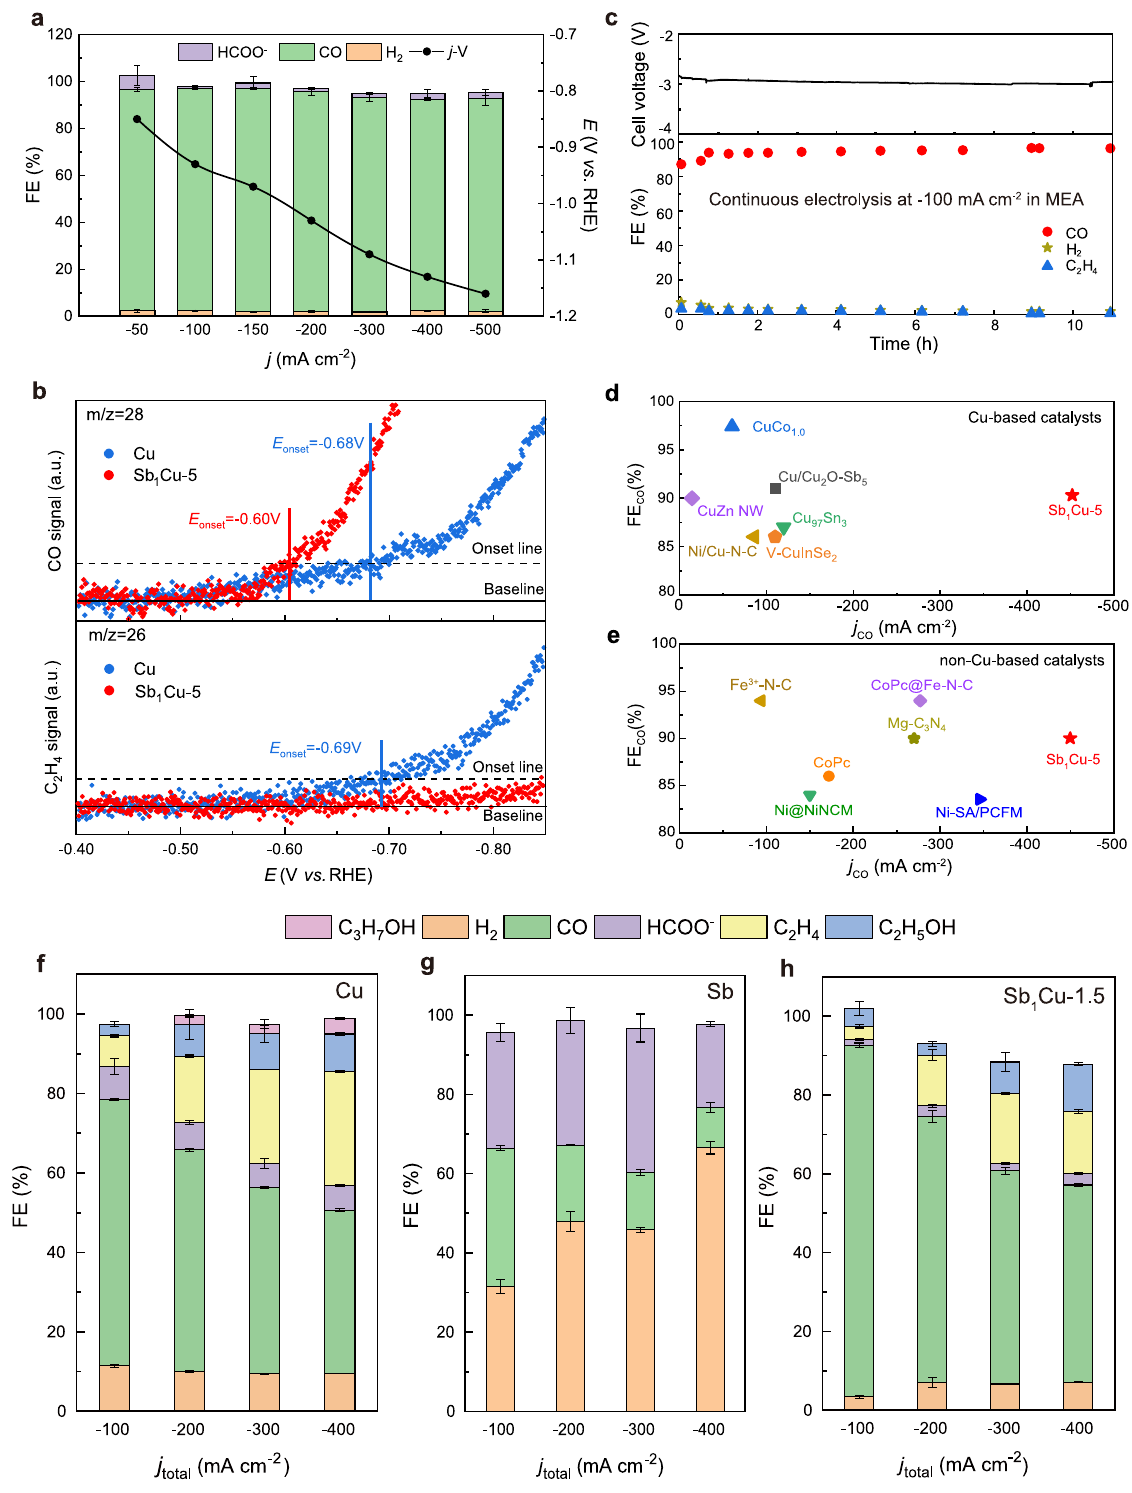
Fig. 2 | CO 2 RR performance over Sb 1 Cu catalysts and Cu. a FEs of all CO 2 RR products at different current densities and the corresponding j -V curve of Sb 1 Cu-5. b InsituDEMSmeasurementof(up)COand(down)C 2 H 4 production during CO 2 RR on Cu and Sb 1 Cu-5 catalysts. c Stability test at − 100 mA cm − 2 current density in MEA for over 10 h, indicating an average CO FE of